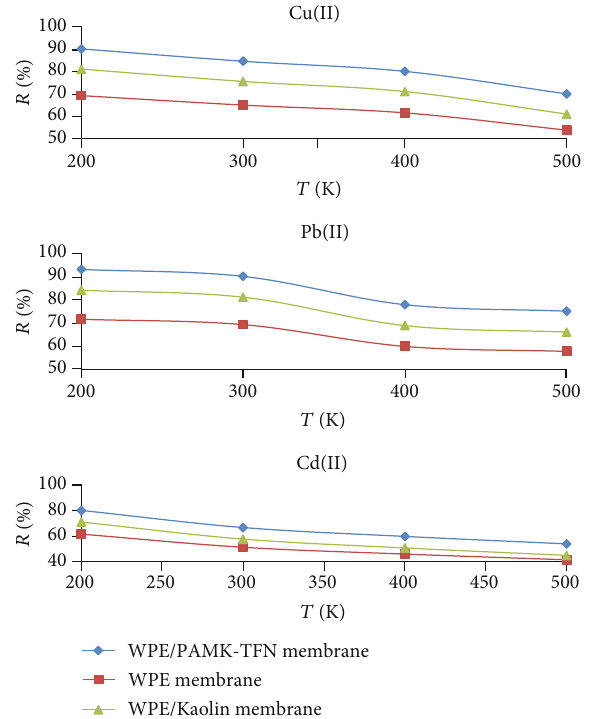
Figure 13: E ff ect of temperature on the rejection of heavy metals on the prepared WPS, WPS/kaolin, and WPE/PAMK-TFN membranes.